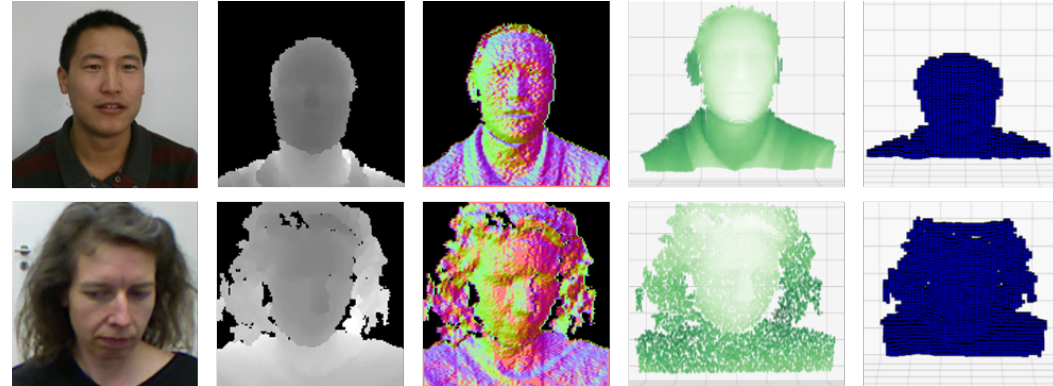
Figure 1. Sample images of different depth representation taken from Lock3DFace dataset [21] ( Time-of-Flight , first row) and Biwi database [22] ( Structured Light , second row). From the left, the RGB, depth and normal images, point clouds, and voxels are